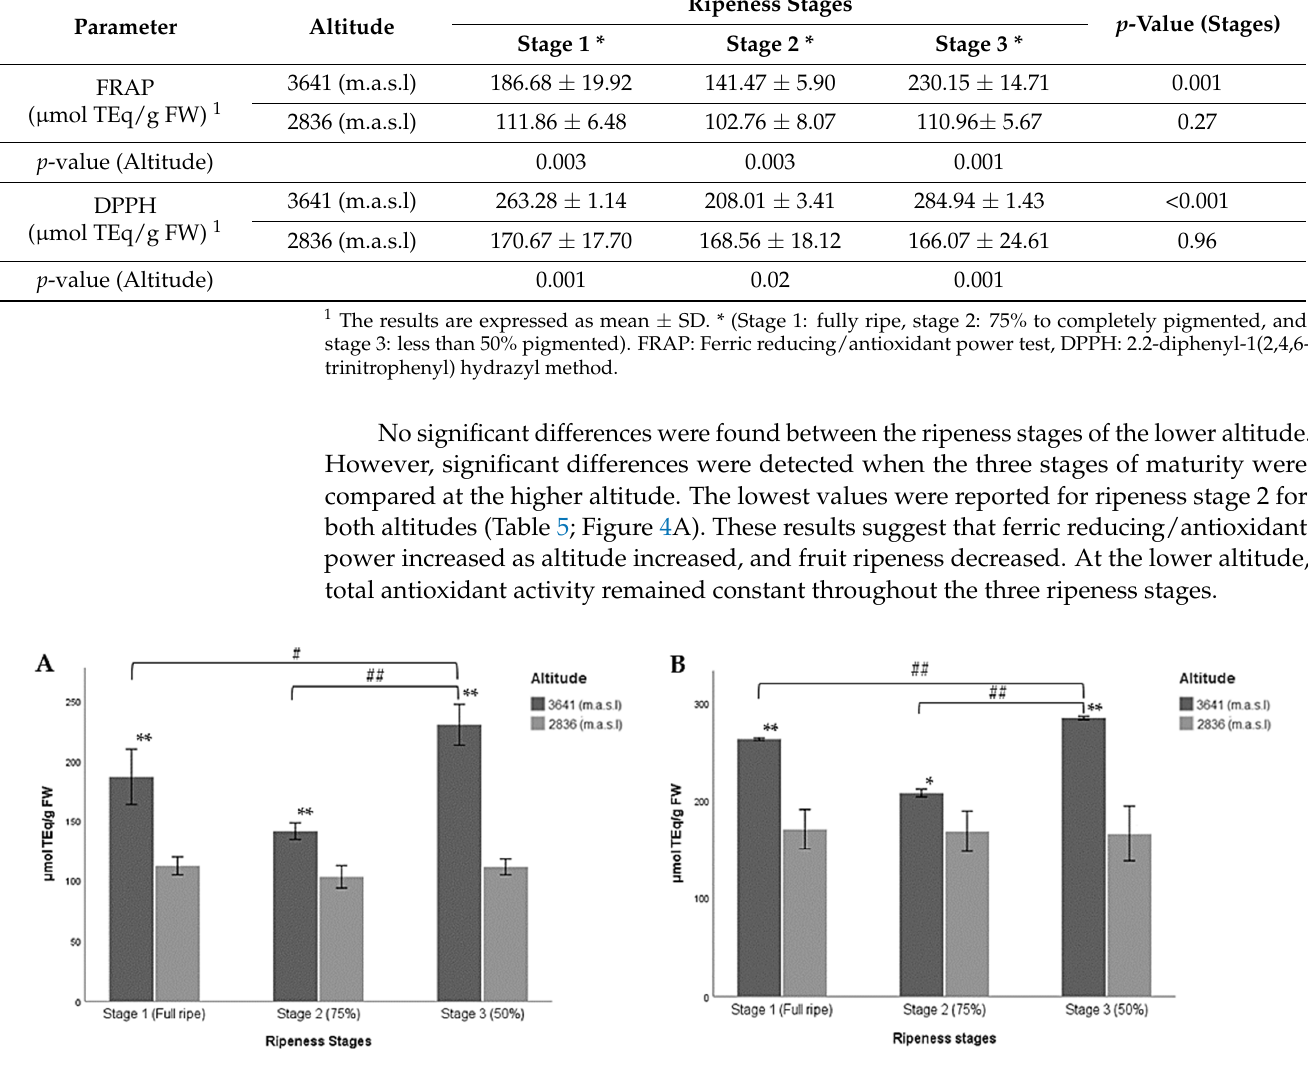
Figure 4. Multiple comparisons of the three ripeness stages of Andean blueberries ( V. floribundum